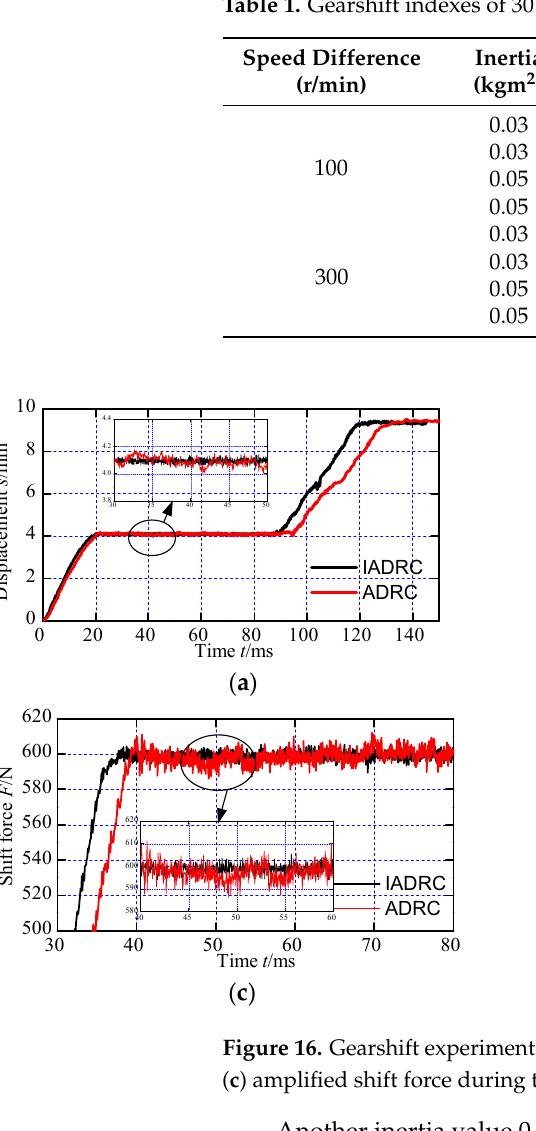
Table 1. Gearshift indexes of 30 times gearshift events.